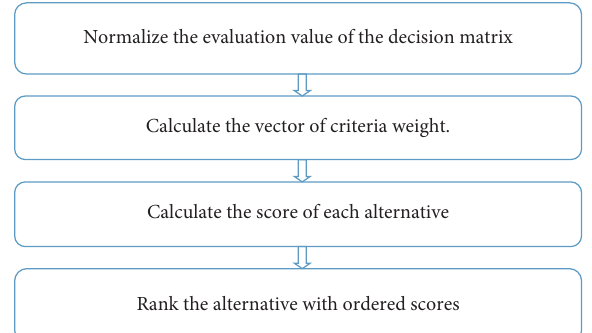
Figure 1: The hierarchical frame of the proposed cross-entropy-based HPFLSs MCGDM